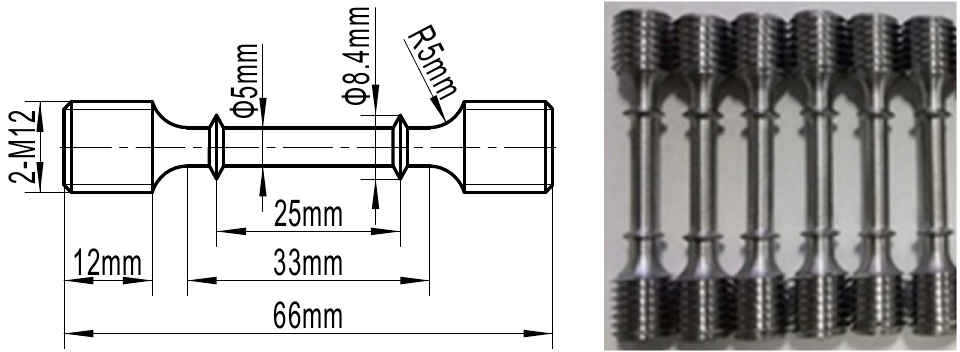
Figure 5. Standard cylindrical tensile specimens of 65Mn low-alloy steel for tensile tests.